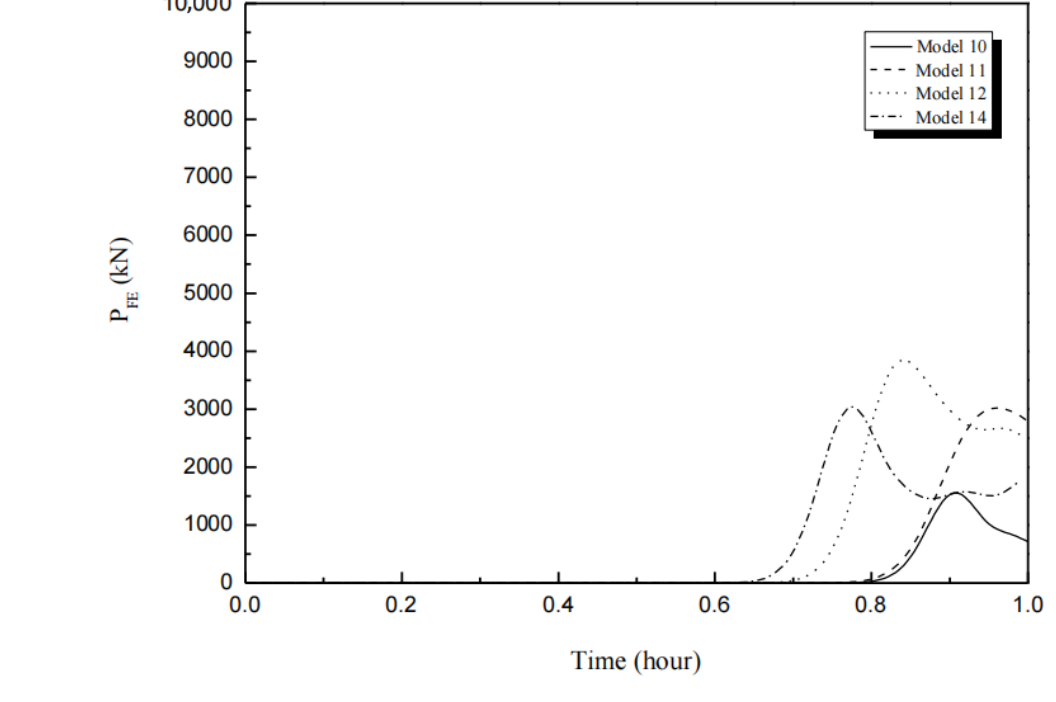
Figure 4. Axial strength versus time for model numbers 10–12 and 14.